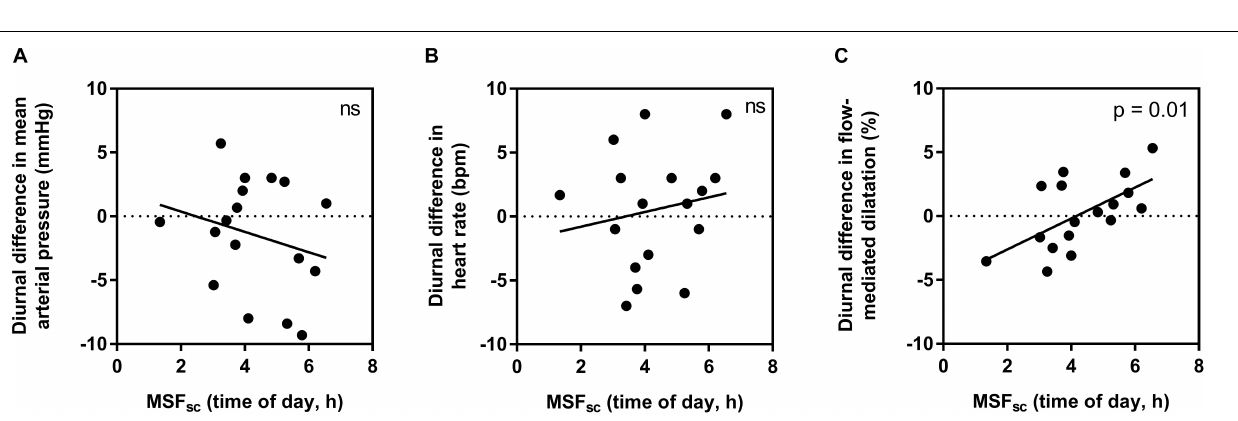
FIGURE 1 | Average measurements between morning (AM, light gray) and evening (PM, dark gray) for mean arterial pressure (A) , heart rate (B) , and flow-mediated dilatation (C) . Significance is shown in the top right corner (ns, not significant).